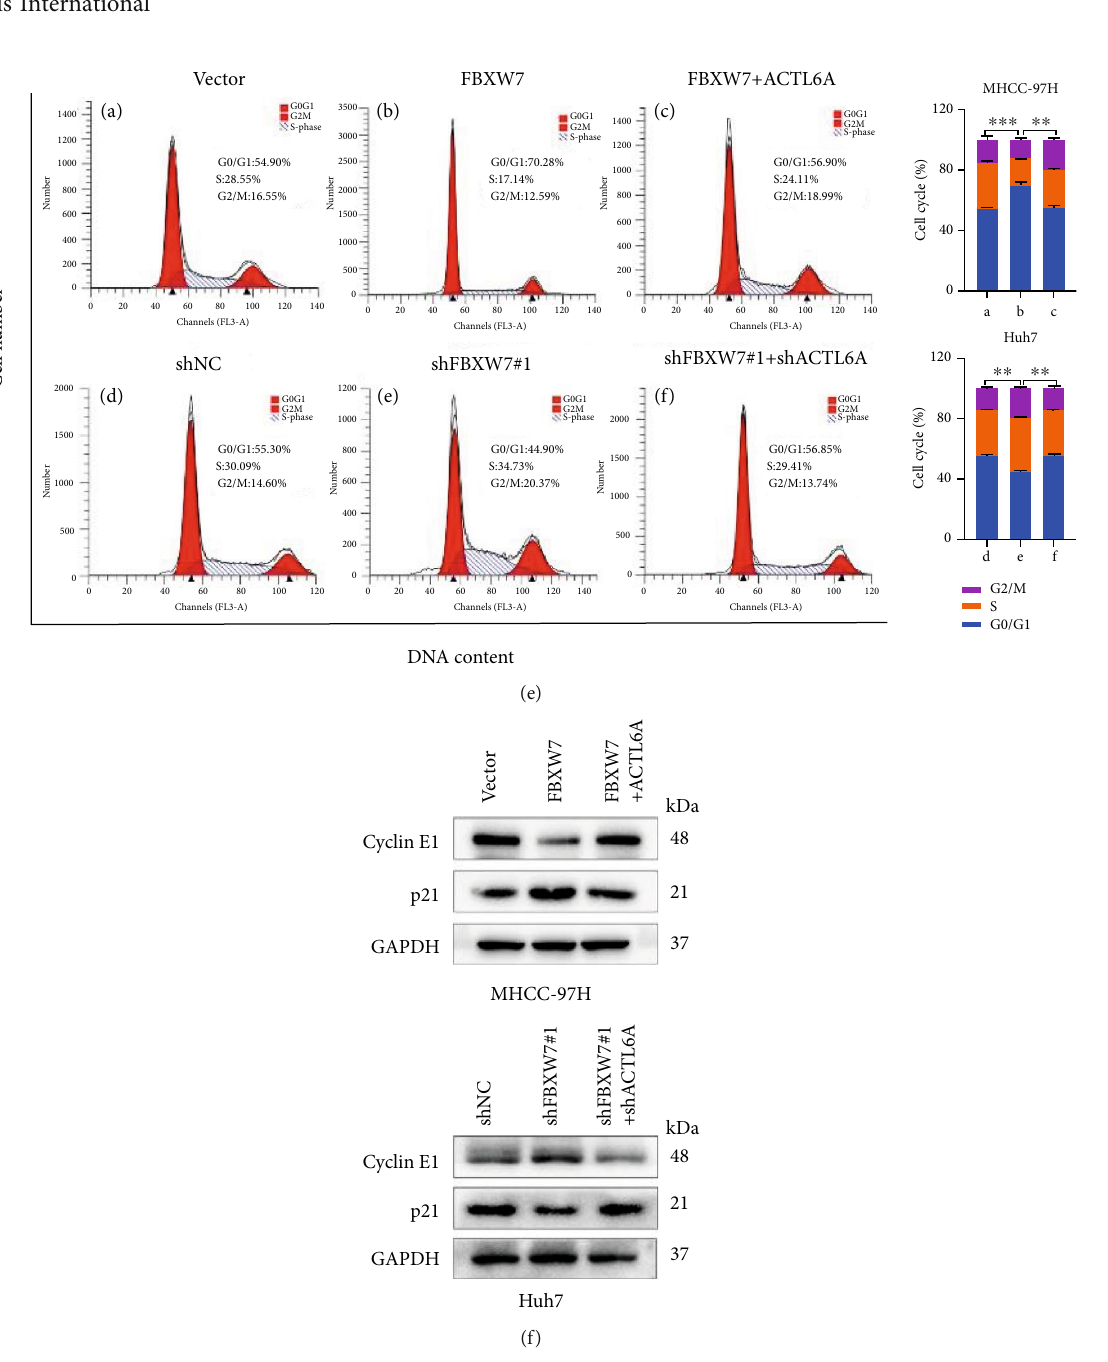
Figure 7: FBXW7 inhibits HCC cell stemness and malignancy by downregulating the levels of ACTL6A. (a) Flow cytometry analysis of the positivity rate of CD133 in di ff erent groups. (b, c) Representative images and quanti fi cation of the size and generation rate of tumor spheres. Scale bars, 100 μ m. (d) Western blot was used to detect the expression of pluripotent transcription factors in HCC cells with FBXW7 or ACTL6A. (e) Representative images and quanti fi cation of cell cycle distribution detected by fl ow cytometry. (f) Expression of cell cycle- related proteins detected by Western blot. Graph represents mean ± SD ; ∗∗ P < 0 : 01 , ∗∗∗ P < 0 : 001